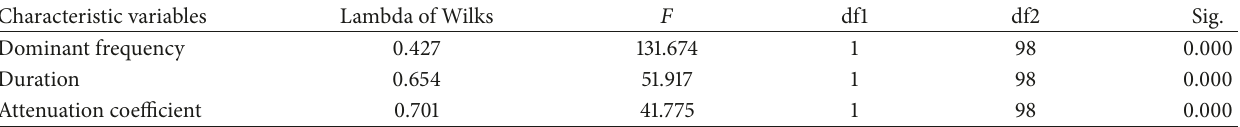
Table 1: Tests of equality of group means.